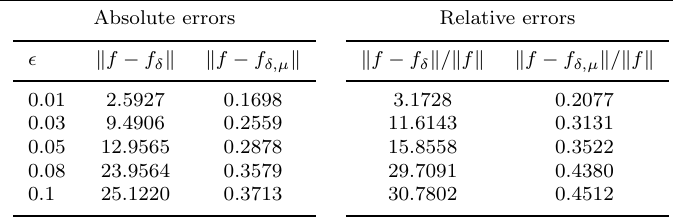
Table 2. Example 2: Errors assuming α 2 = 2 , β = 0 ,ν = 1 ,t 0 = 1 ,p = 1. Absolute errors Relative